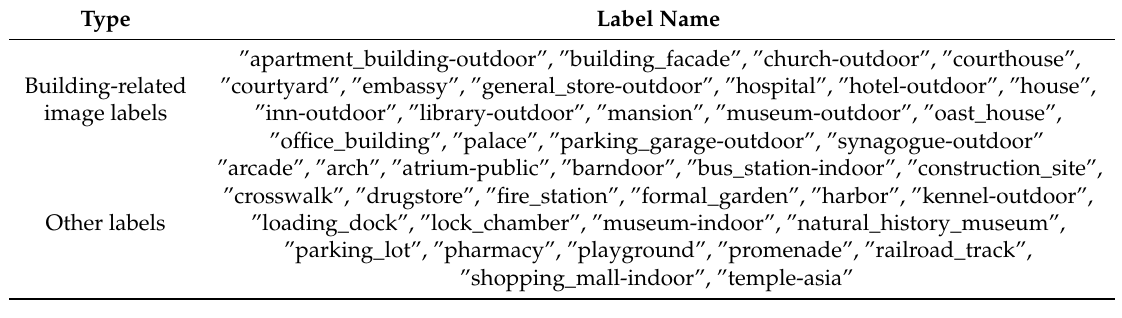
Table 1. Building-related image labels and other labels.